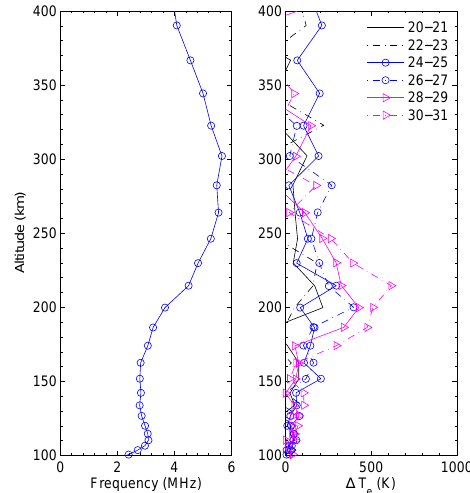
Figure 2. The measured UHF radar plasma frequency and electron temperature enhancement (cid:49)T e during 19:24–19:30UT on 3 July 2012. Note that the reflection altitude is approximately 215km for the pump frequency 4.04MHz.